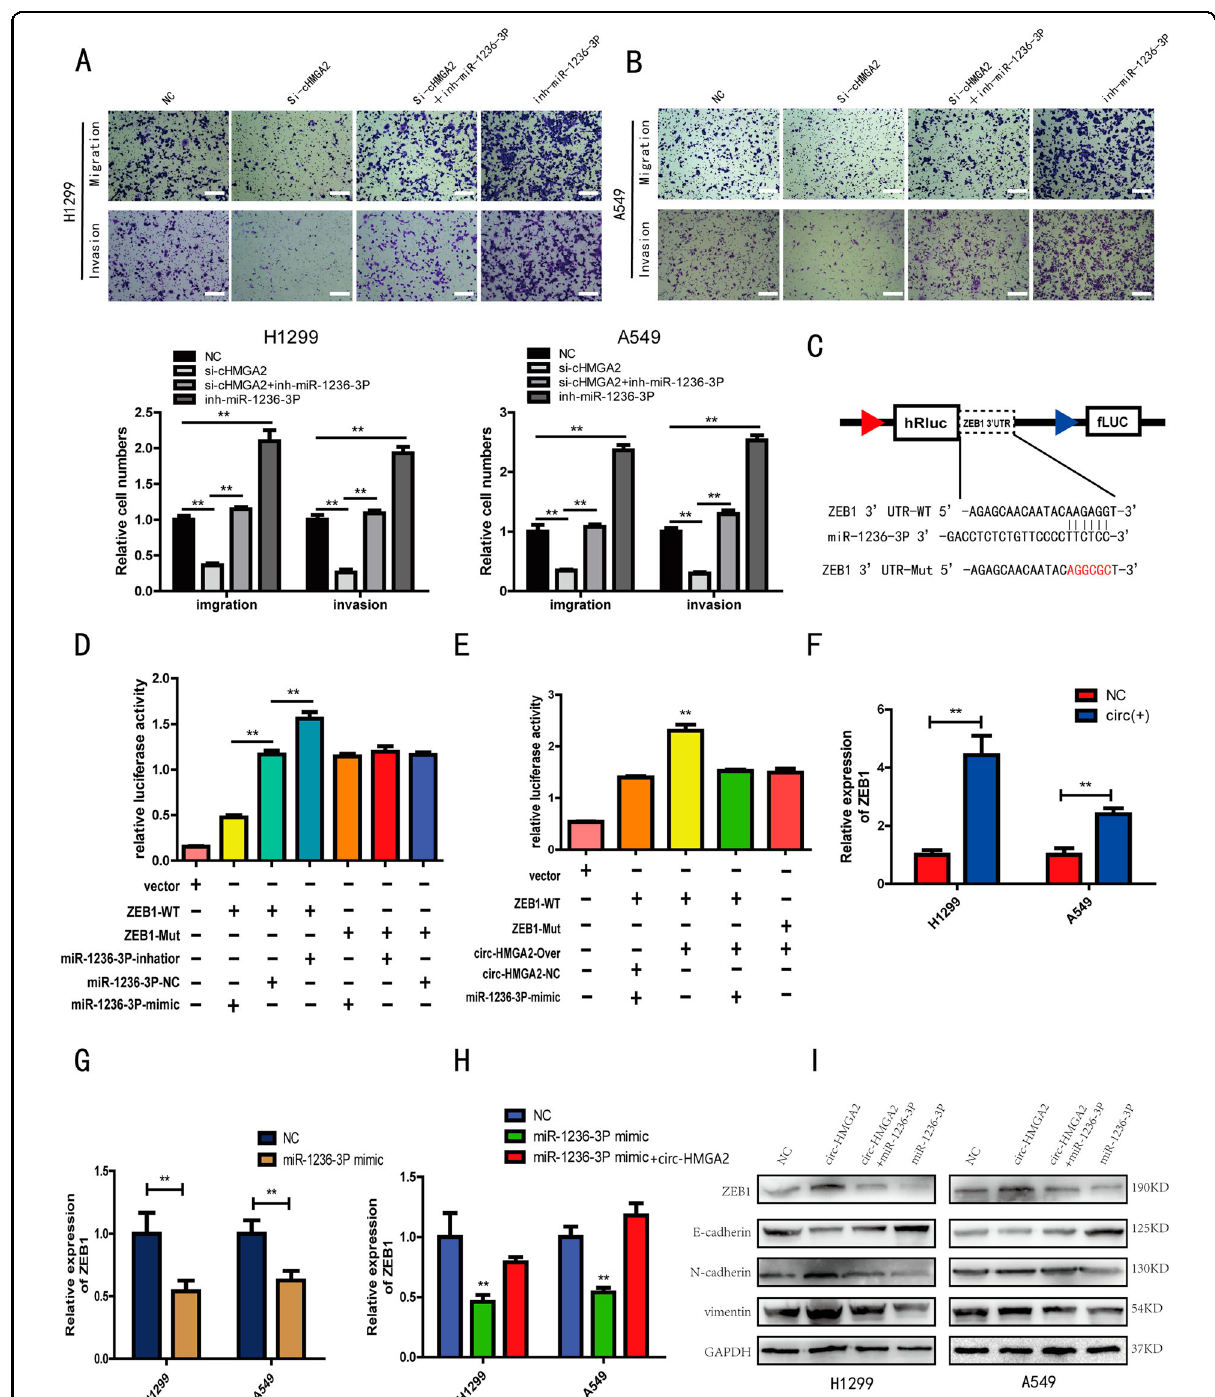
Fig. 6 The circ-HMGA2/miR-1236-3p/EMT axis regulates LUAD cell metastasis. A , B The results of transwell assays showed that miR-1236-3p inhibited the promotive effect of circ-HMGA2 on LUAD metastasis. Scale bar: 200 μ m. C Schematic of luciferase reporter vectors containing wild-type (WT) and mutant (Mut) ZEB1. D Luciferase activity was analyzed in 293T cells after co-transfection with miR-1236-3p mimics, miR-NC or miR-1236-3p inhibitors, and the WT or Mut luciferase reporter vectors. E Luciferase activity was analyzed in 293T cells after co-transfection with miR-1236-3p mimics, circ-HMGA2-NC or circ-HMGA2-over, and the WT or Mut luciferase reporter vectors. The relative luciferase activity was presented by the relative hRluc/hluc ratio. F The qRT-PCR results showed that circ-HMGA2 signi fi cantly increased the expression of ZEB1. G The qRT-PCR results showed that miR-1236-3p signi fi cantly inhibited the expression of ZEB1. H , I The mRNA and protein levels of ZEB1 and EMT was not changed after co-transfection with miR-1236-3p mimics and circ-HMGA2. ** P <